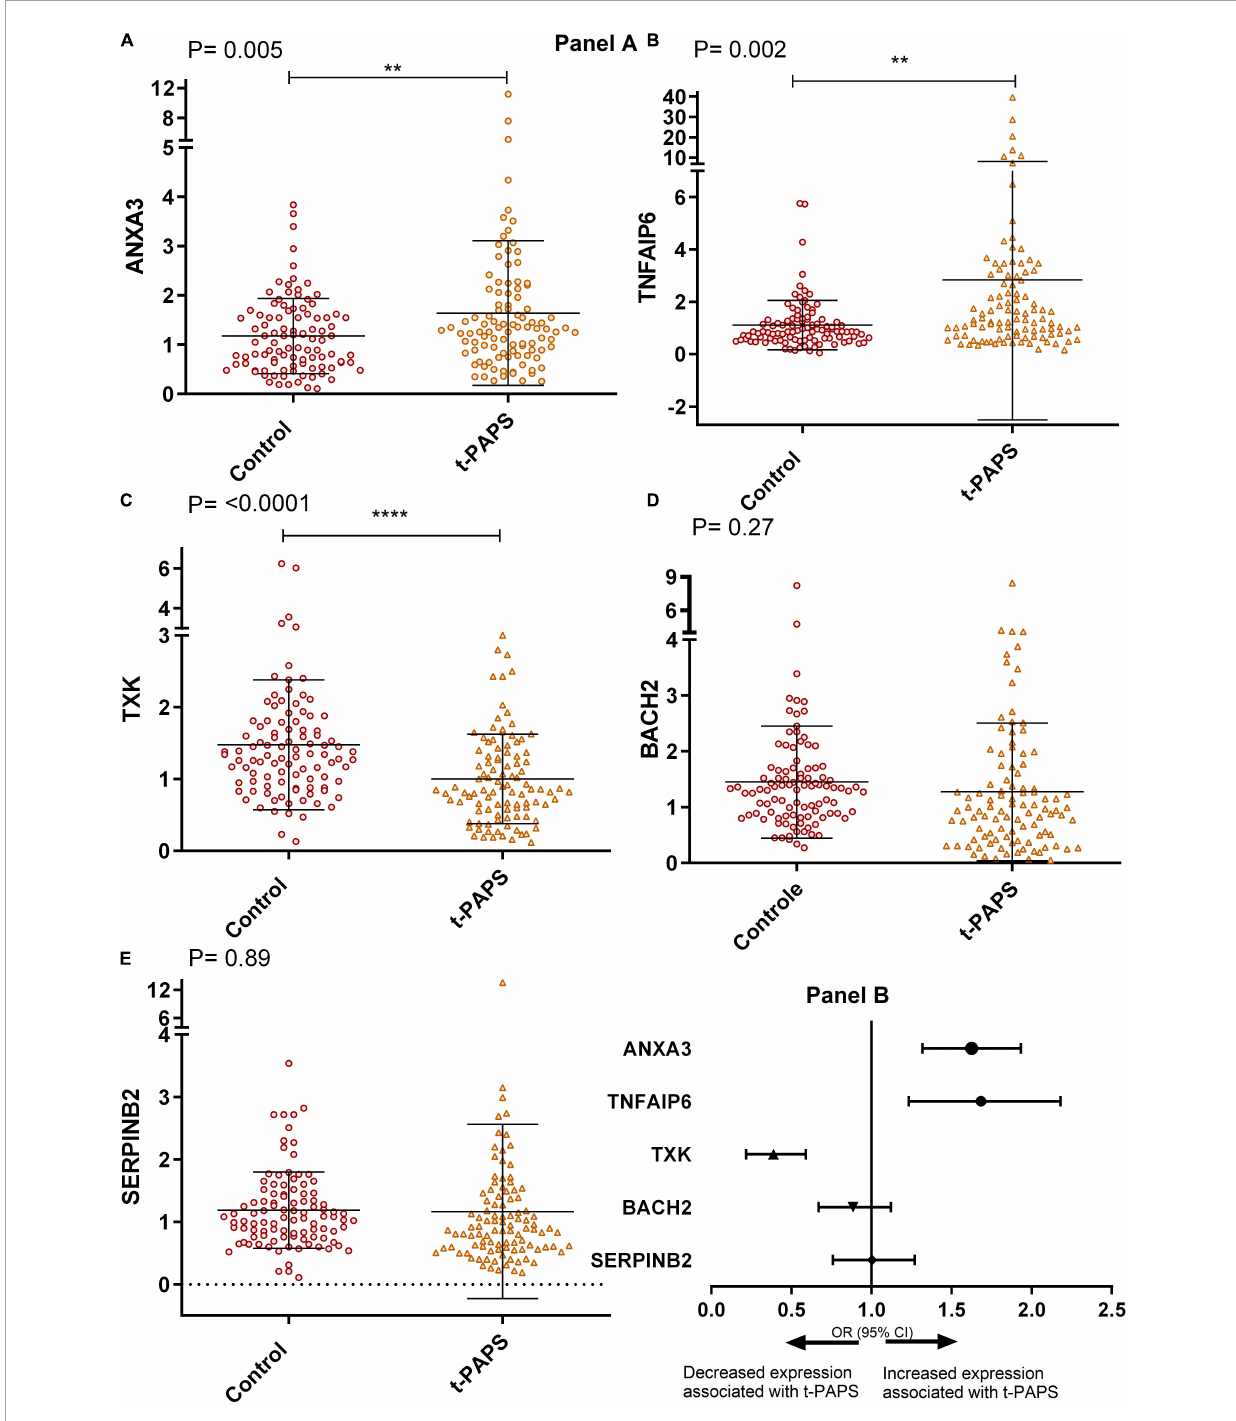
FIGURE2 Panel (A) comparative graphs of the expression of genes related to thrombosis. Relative expression in total leukocytes of the genes: (A) ANXA3 , (B) TNFAIP6 , (C) TXK , (D) BACH2, and (E) SERPINB2 . To illustrate the graphs above, mean and SD were used, and P -values were calculated using Student’s t -test. t-PAPS = primary thrombotic APS. The mean ANXA3 mRNA expression was 1.17 AU [95% CI 1.03–1.33] in controls and 1.64 AU [95% CI 1.36–1.93] in t-PAPS [ P = 0.005]. The mean TNFAIP6 expression was 1.10 AU [95% CI 0.92–1.29] in controls and 2.84 [95% CI 1.89–3.89] in t-PAPS [ P = 0.002]. The mean TXK expression was 1.47 AU [95% CI 1.30–1.66] in controls and 1.00 AU [95% CI 0.88–1.12] in t-PAPS [ P = < 0.0001]. The mean BACH2 expression was 1.45 AU [95% CI 1.25–1.65] in controls and 1.27 AU [95% CI 1.03–1.52] in t-PAPS [ P = 0.27]. Finally, the mean SERPINB2 expression was 1.19 AU [95% CI 1.07–1.31] in controls and 1.17 AU [95% CI 0.89–1.44] in t-PAPS [ P = 0.89]. Panel (B) association of ANXA3 , TNFAIP6 , TXK , BACH2, and SERPINB2 relative expression with t-PAPS diagnosis. Increased ANXA3 mRNA expression [OR = 1.57; 95% CI 1.13–2.18; P = 0.008] and TNFAIP6 expression [OR = 1.64; 95% CI 1.23–2.18; P = 0.001] and decreased TXK mRNA expression [OR = 0.36; 95% CI 0.22–0.59; P = 0.0001] were associated with a higher risk of t-PAPS compared with controls. BACH2 and SERPINB2 mRNA expression was not associated with t-PAPS [OR = 0.87; 95% CI 0.67–1.12; P = 0.28 and OR = 0.98; 95% CI 0.75–1.3; P = 0.89, respectively]. OR, odds ratio; CI, confidence interval; t-PAPS, primary thrombotic APS. ** P < 0.01 and **** P = <